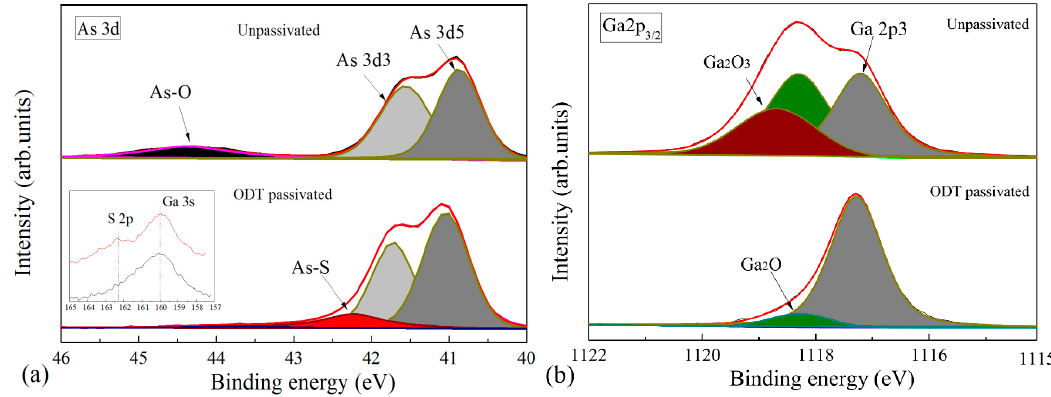
Figure 1. ( a ) As 3d ( b ) Ga 2p3/2 XPS spectra of unpassivated and ODT treated GaAs